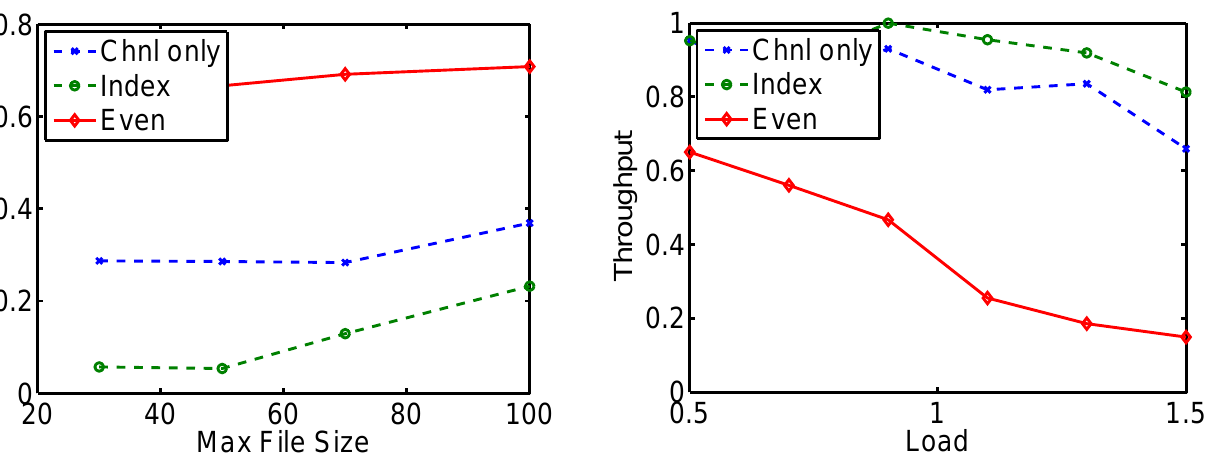
Figure 10. Throughput when Index Policy Objective is Minimizing Missed Deadlines, Real-life Trace works well in our simulations by opportunistically favor users in good channel conditions.